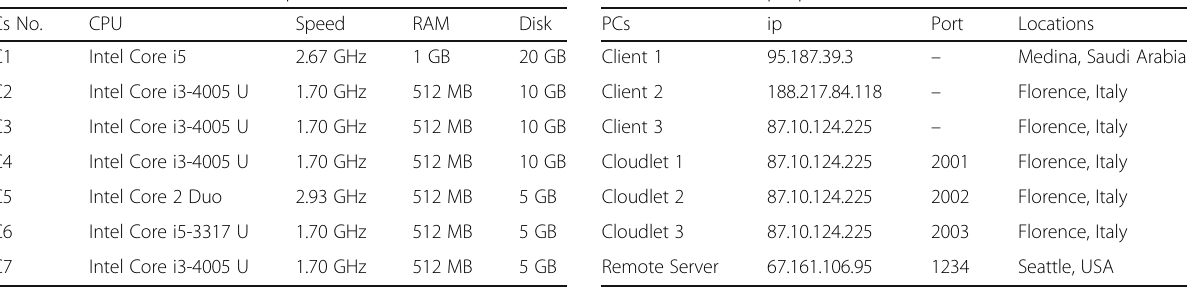
Table 3 Table of ips, ports and locations